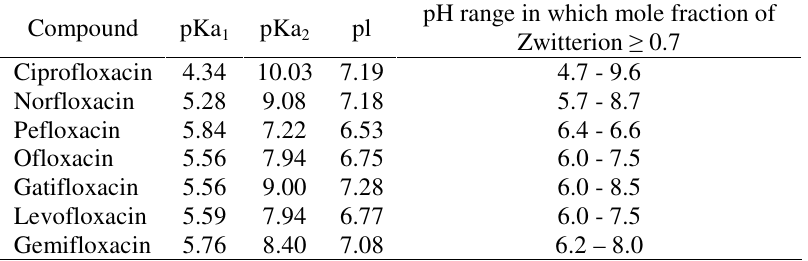
Table 2. Dissociation constant, isoelectric point and pH dependent distribution of zwitterions for some fluoroquinolones